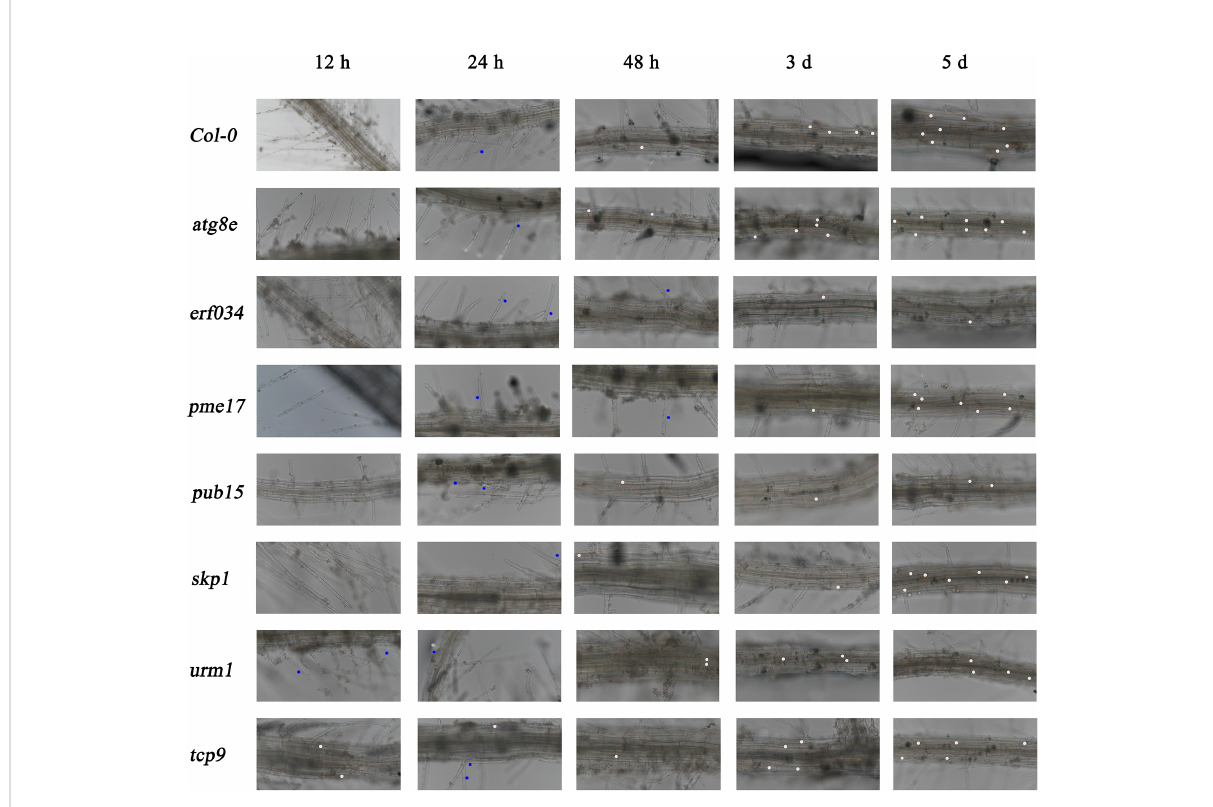
FIGURE 6 Roots observation of A. thaliana inoculated with P. brassicae in hydroponic culture. Blue dots indicate the P. brassicae of root hair-infected stage, white dots indicate the P. brassicae of